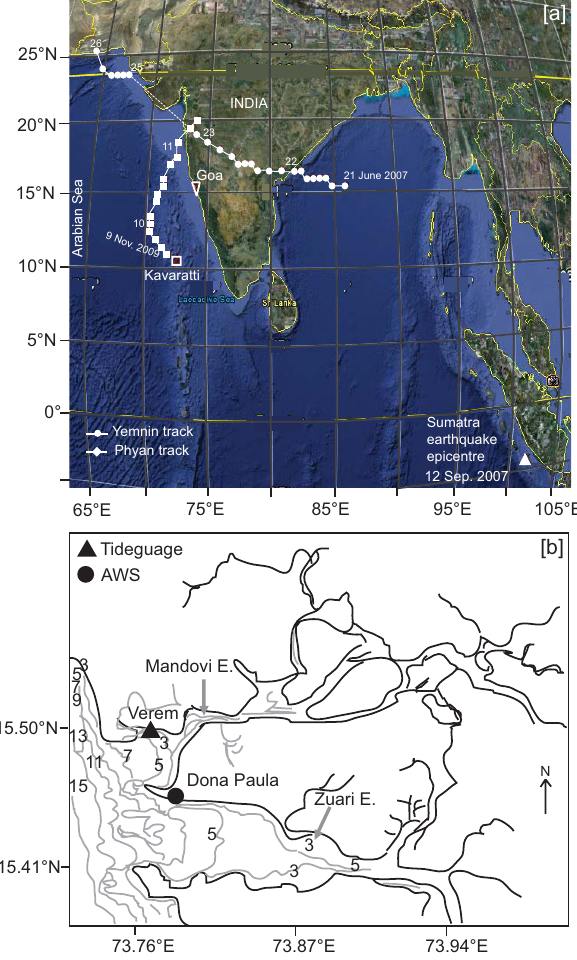
Fig. 1. The study region at the west coast of India in the Ara- bian Sea (a) along with the cyclone tracks of Yemnin and Phyan (www.imd.gov.in) and also indicting the 12 September 2007 Suma- tra earthquake epicentre; (b) the locations of automatic weather sta- tion (AWS) and tide gauge station in Mandovi estuary region ( b is adapted from Fig. 1, Sundar and Shetye,